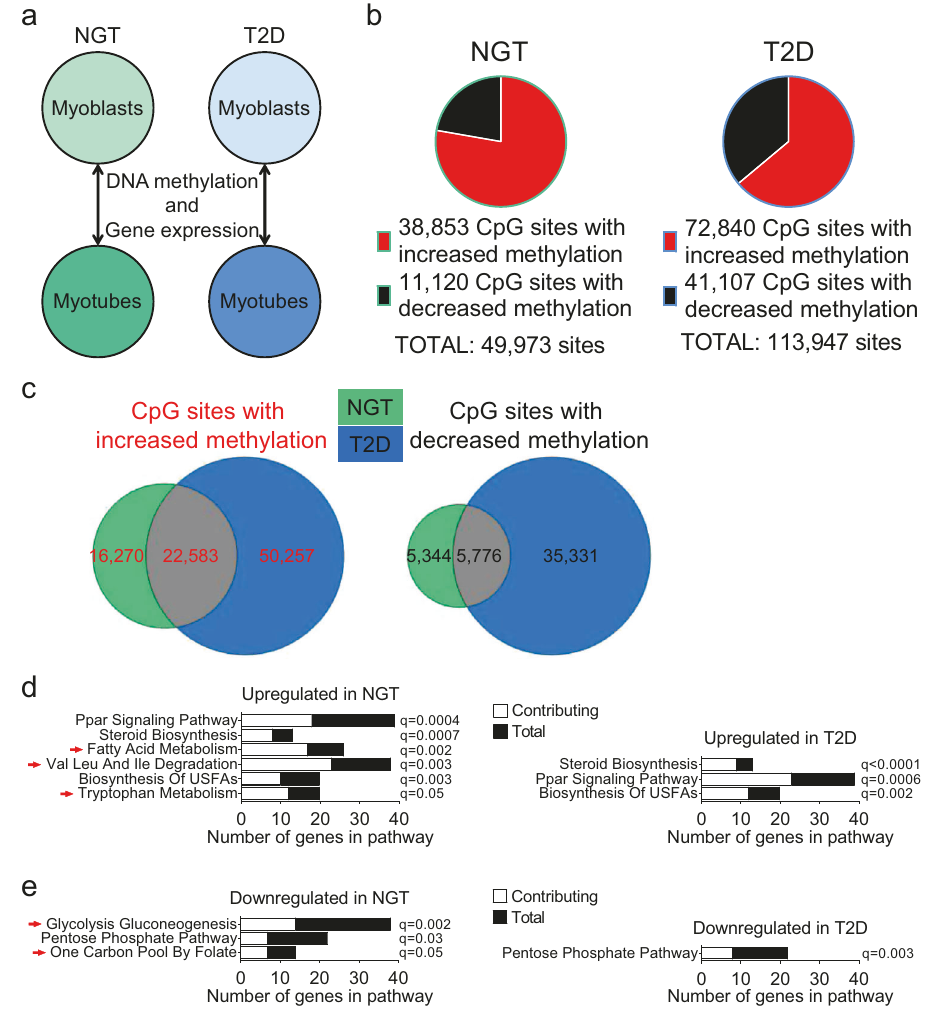
Fig. 7 Differential changes in DNA methylation and gene expression during differentiation of human muscle cells from individuals with T2D versus controls. a Schematic representation of the analyses performed to compare the myogenic process in cells from individuals with type 2 diabetes (T2D) and controls (NGT, normal glucose tolerance). b Number of CpG sites with signi fi cantly ( q < 0.05) increased (red) or decreased (black) DNA methylation before vs. after muscle cell differentiation in individuals with NGT (left panel) and T2D (right panel) (see also Supplementary Data 6, Sheets B and C). n = 14 individuals per group. c Overlap of the CpG sites with signi fi cantly ( q < 0.05) increased (left panel) or decreased (right panel) methylation in